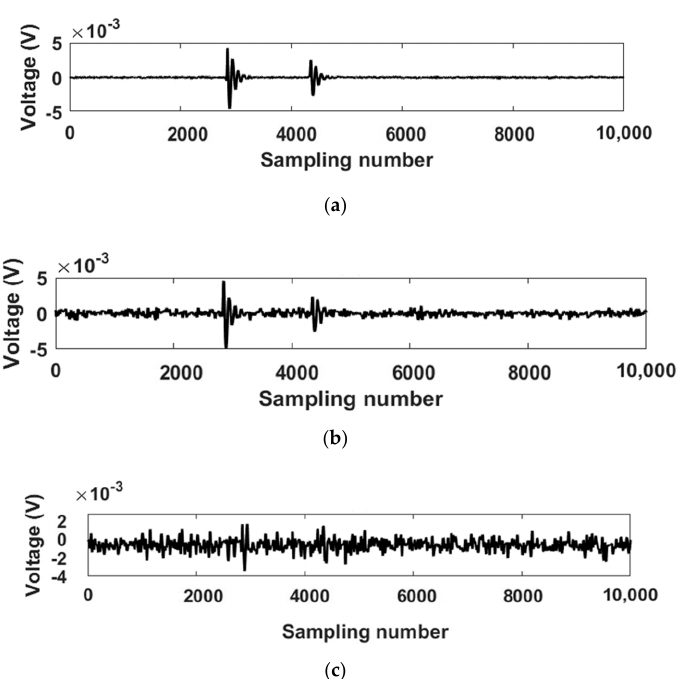
Figure 9. ( a ) De ‐ noised PD signals with 4 dB SNR. ( b ) De ‐ noised PD signals with − 10 dB SNR. ( c ) Figure 9. ( a ) De-noised PD signals with 4 dB SNR. ( b ) De-noised PD signals with − 10 dB SNR. ( c ) De ‐ noised PD signals with − 18 dB SNR. De-noised PD signals with − 18 dB